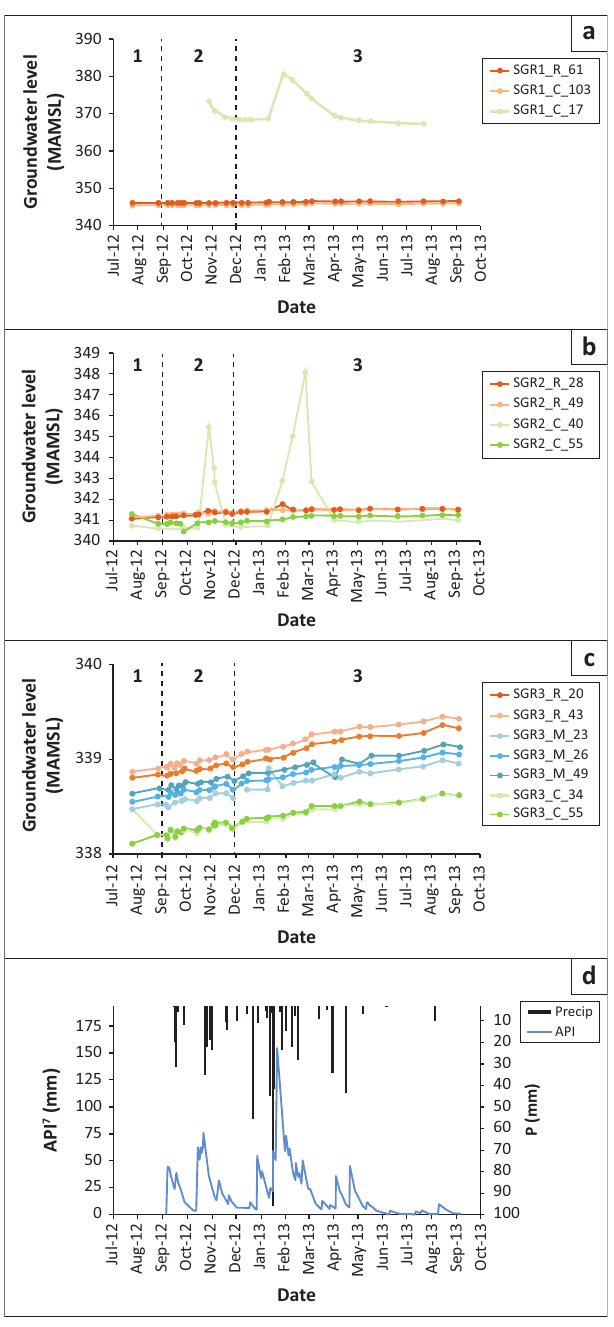
Seven-day Antecedent Precipitation Index periods (1, 2 and 3) separated by vertical dashed lines and Y-axis variations for each groundwater level series, crest, midslope, riparian, respectively. API 7 , Seven-day Antecedent Precipitation Index; C, crest; M, midslope; R, riparian. FIGURE 3: Groundwater hydrodynamics and seven-day Antecedent Precipitation Index for Kruger National Park Granite Supersite 2012–2013.